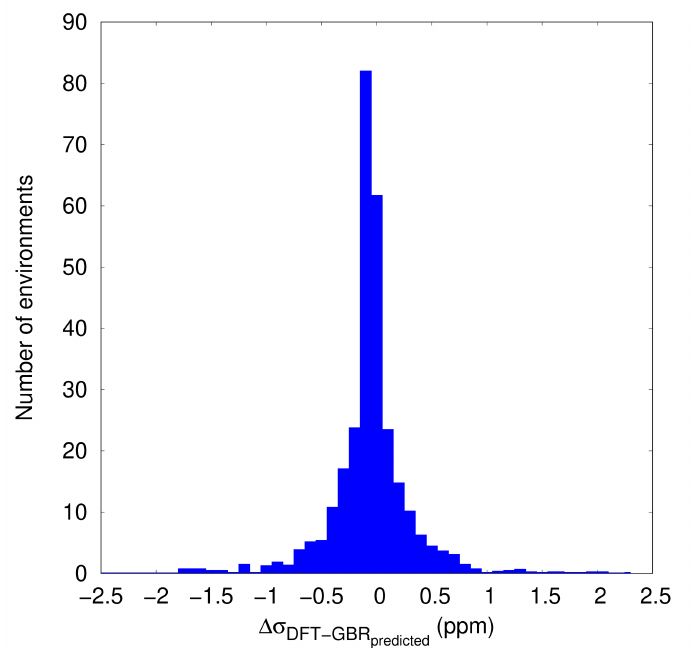
Figure 4. Distribution of the differences between the isotropic shielding values computed with DFT and those predicted with the ML-GBR method. All atomic environments are considered. The his- tograms are obtained with an interval of 0.1 ppm in the count of the number of atomic environments.